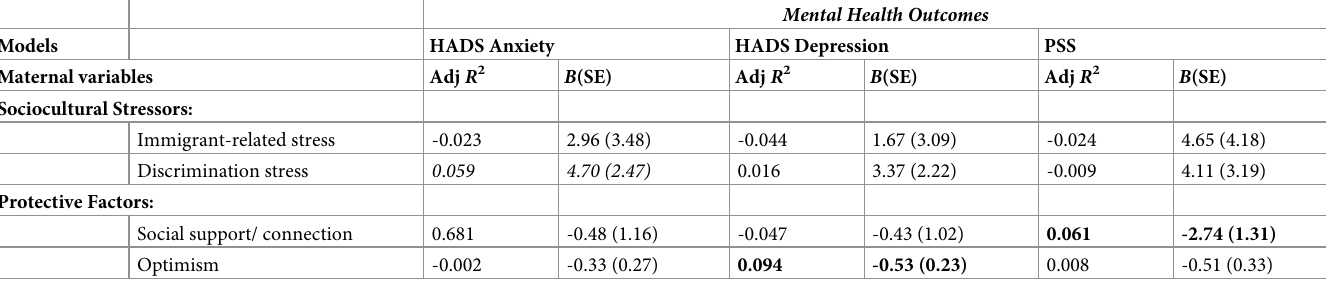
Table 4. Linear regression models of maternal sociocultural variables explaining mental health symptoms at follow-up in the interior city (n =